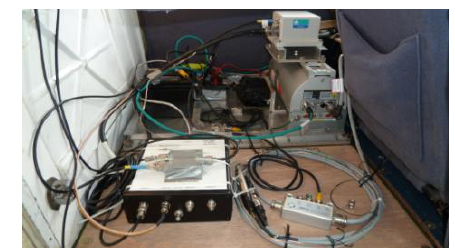
Figure 6. GPS software receiver (left front) and LiDAR equipment (rear) secured in the aircraft.